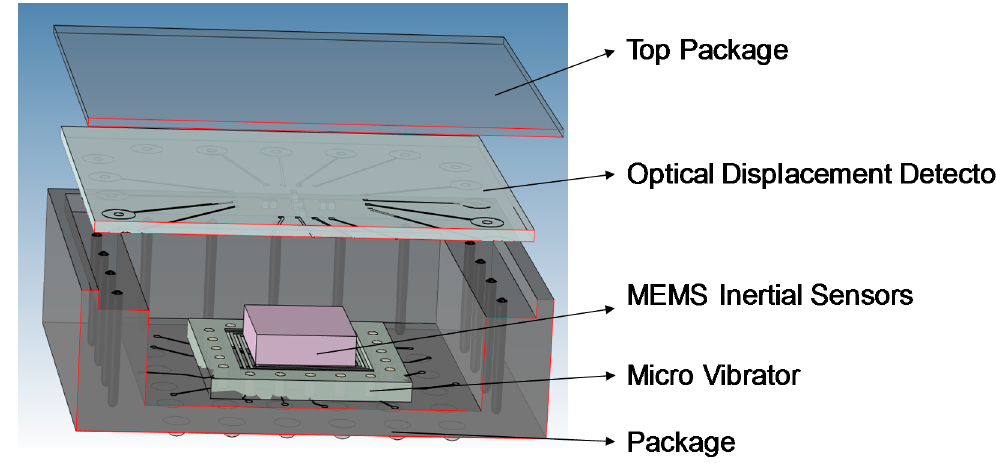
Figure 1. Graphical overview of the proposed microsystem architecture for in-situ self-calibration of MEMS inertial sensors.